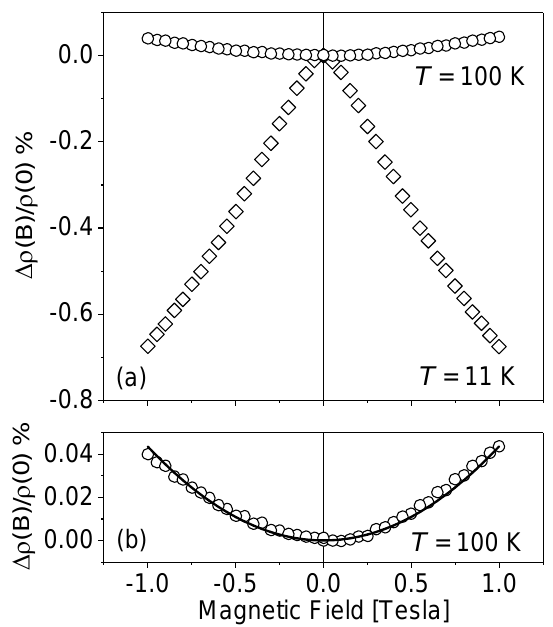
Figure 2. Relative variation of resistivity ∆ ρ ( B )/ ρ (0) vs. magnetic field B . ( a ) Results for sample M5, respectively, at T = 100 K (circles) and T = 11 K (diamonds). ( b ) Zoom on 100 K results. Solid line: Gauss model Δ ρ ( B )/ ρ (0) = β × B ² with the fitting parameter β = 4.1 × 10 −4 ( T − ²).